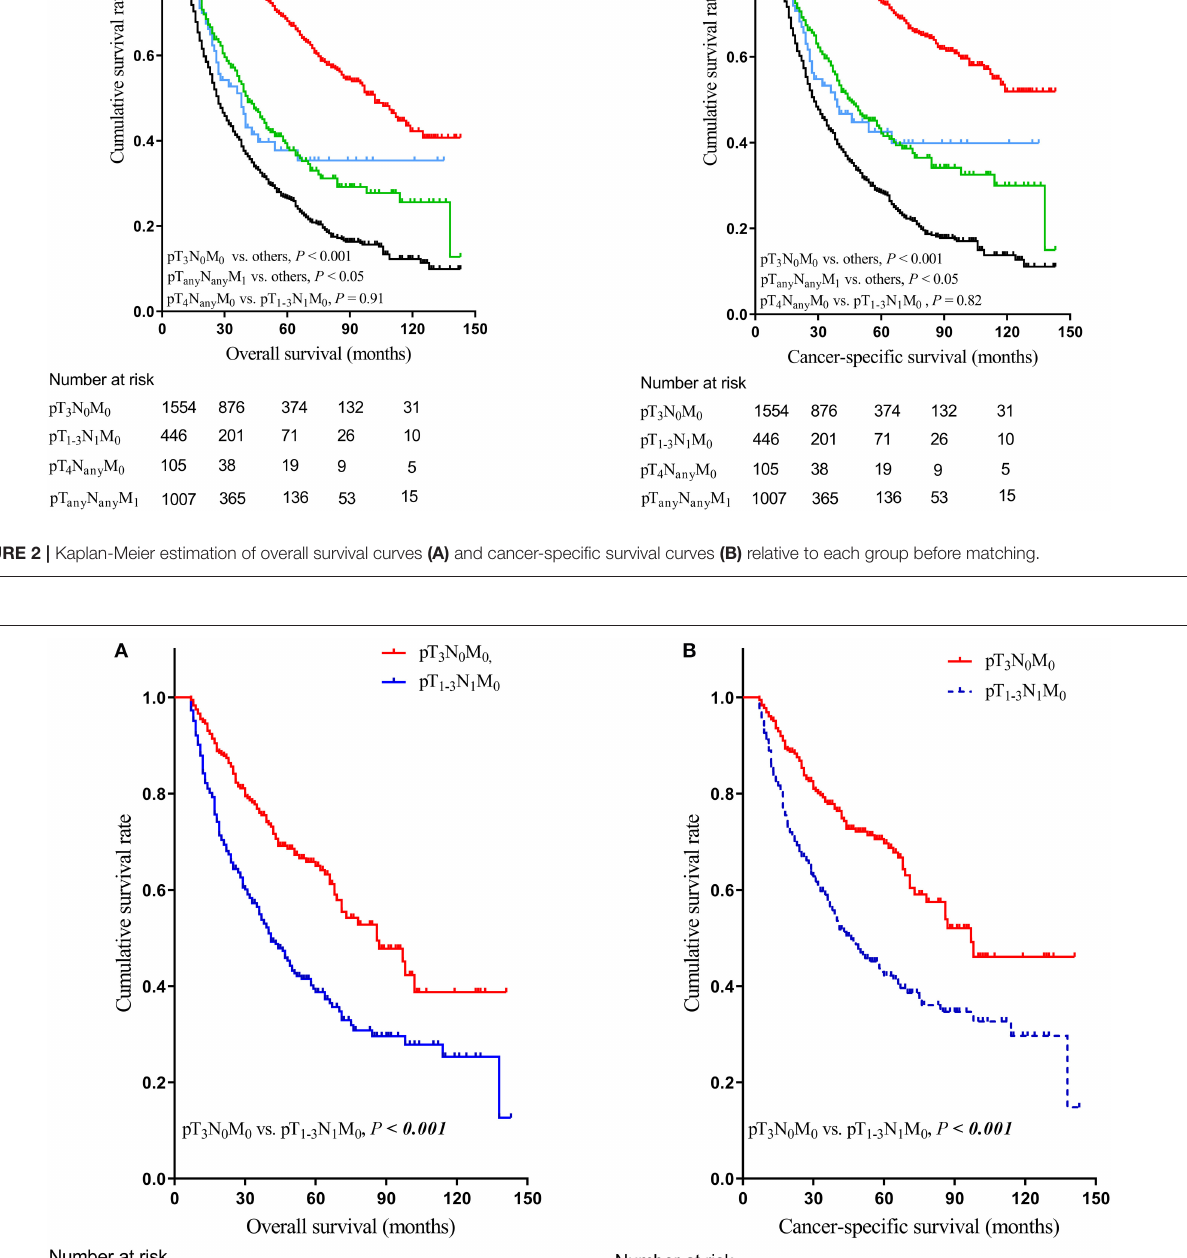
Frontiers in Oncology |